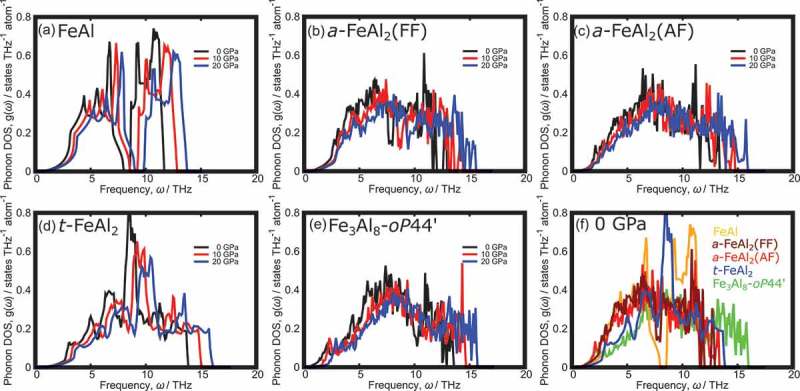
Phonon density of states (DOS) of (a) FeAl, (b) a-FeAl2(FF), (c) a-FeAl2(AF), (d) t-FeAl2, (e) Fe3Al8-oP44ʹ and (f) all structures at 0 GPa. The phonon DOS of a-FeAl2 and Fe2Al5 show enhanced low-frequency phonons, which can contribute to vibrational entropy.